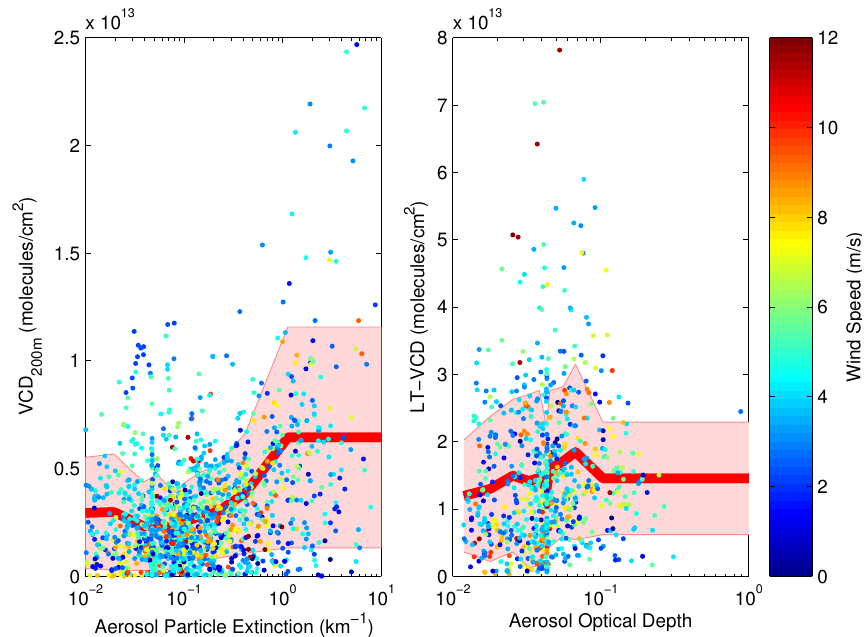
Figure 13. The left panel shows the relationship between the BrO VCD 200m and the near-surface aerosol particle extinction. The right panel shows the relationship between the BrO LT-VCD and the aerosol optical depth. In both plots the x axis is a log scale. The red line represents the mean VCD, calculated from deciles on the x axis, while the shaded region represents 1 standard deviation. In both cases, the coloration indicates the wind